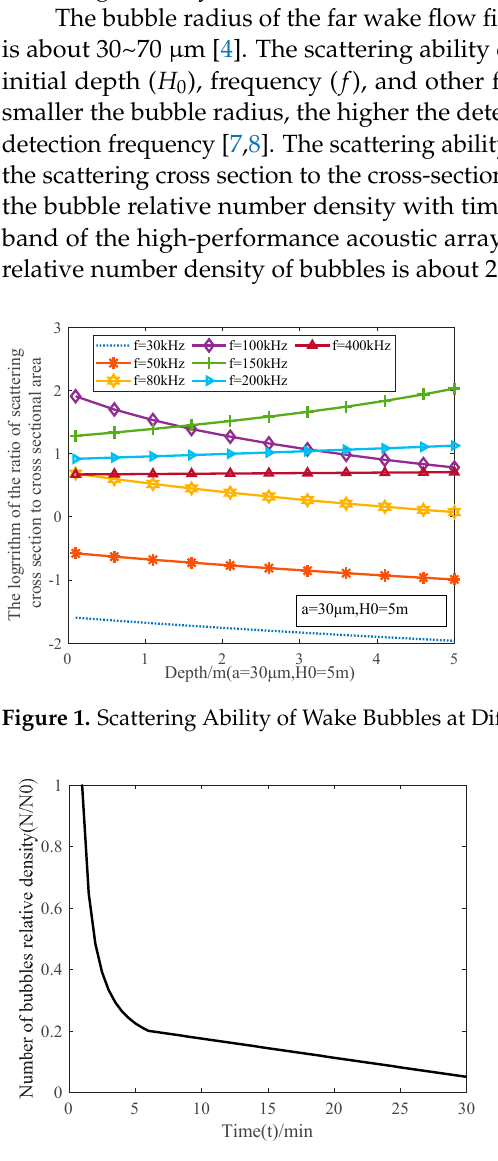
Figure 2. Variation Curve of Bubble Relative Number Density.